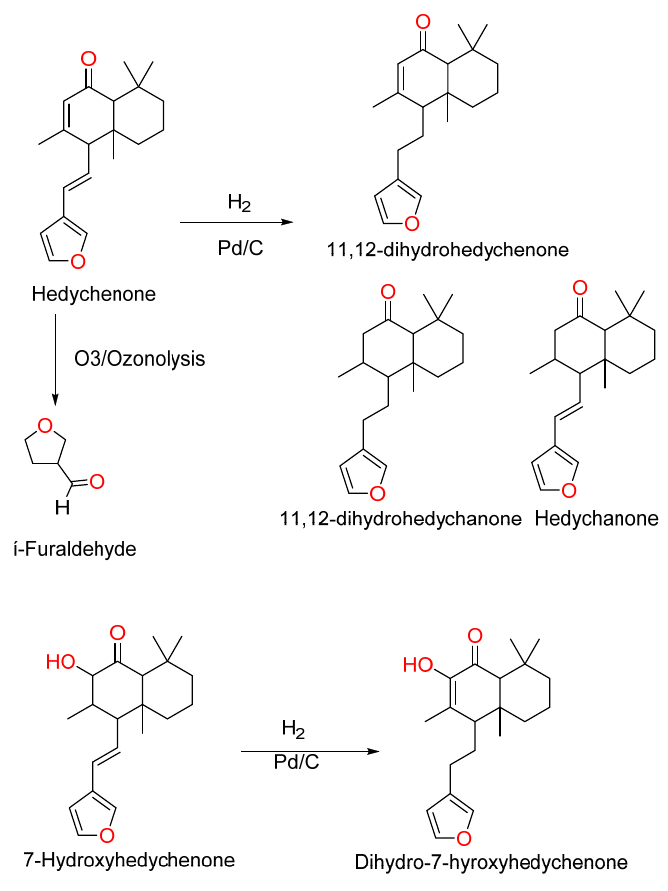
Figure 3. Reaction scheme for hydrogenation of Hedychenone and 7-Hydroxyhedycheno.